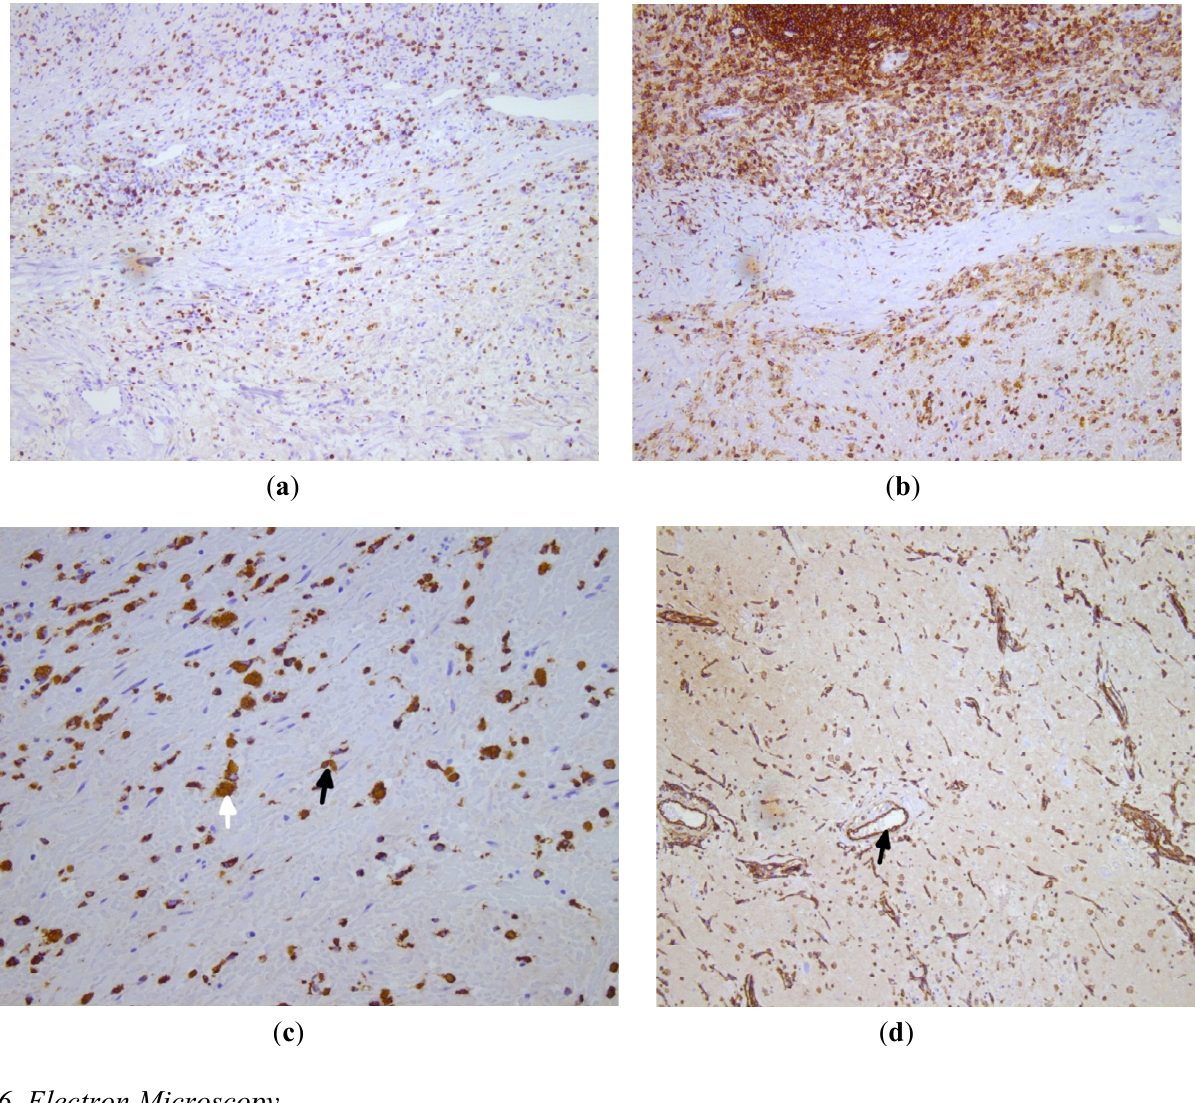
Figure 9. Sections from cardiac myxoma show ( a ) CD8 positive T lymphocytes; ( b ) CD45 positive cells; ( c ) CD68 positive macrophages (black arrow) and hemosiderin-laden macrophages (white arrow); ( d ) CD31 positivity in the blood vessels (black arrow); (Original magnification: ( a – c ) ×10; ( d )